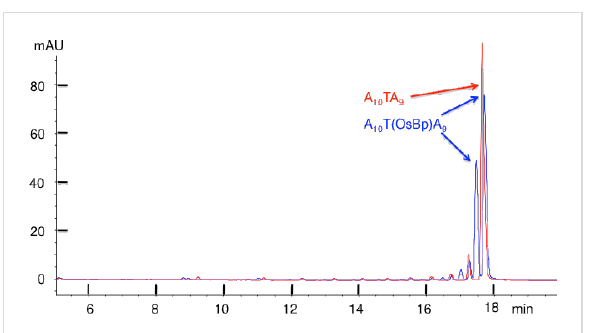
Figure 6: Overlapping IE HPLC profiles of intact and osmylated oligo A 10 TA 9 to show that the main peak (red) upon osmylation yields two product peaks (blue). This observation is consistent with the notion that OsBp adds from either side of the C5–C6 double bond in T.